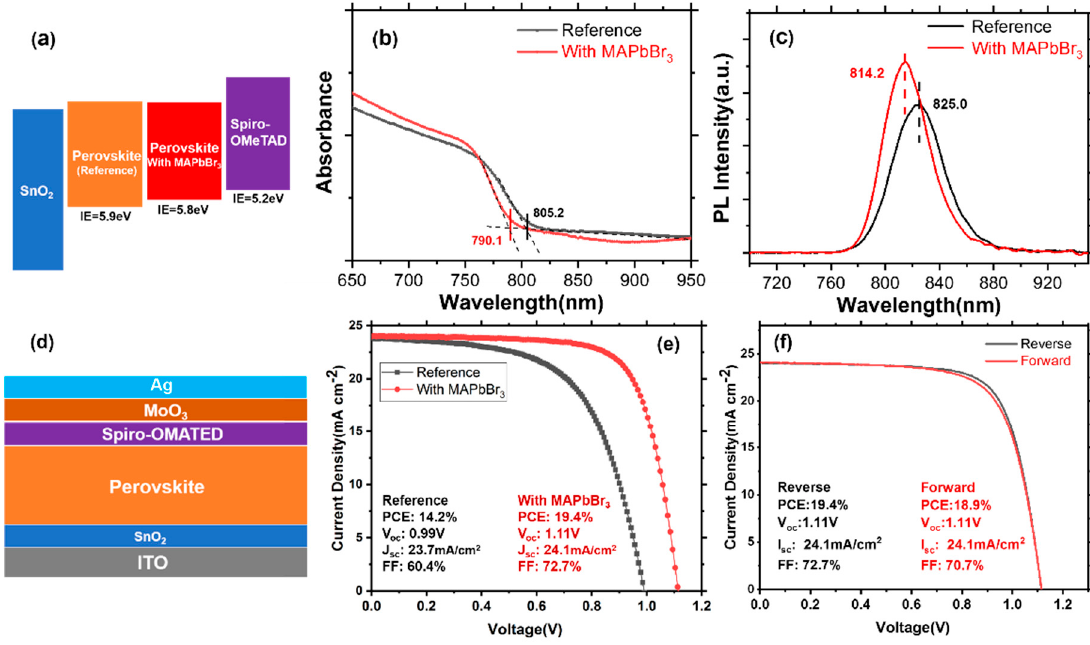
Figure 7. ( a ) The energy level diagram for the SnO 2 /perovskite/sprio-OMeTAD PSCs; ( b ) the absorption spectrum of perovskite on quartz; ( c ) the PL spectrum of perovskite on quartz; ( d ) the device architecture; ( e ) J-V curves of PSCs based on films with and without MAPbBr 3 additive; ( f ) J-V curves of perovskite with MAPbBr 3 devices prepared for both forward and reverse scans.